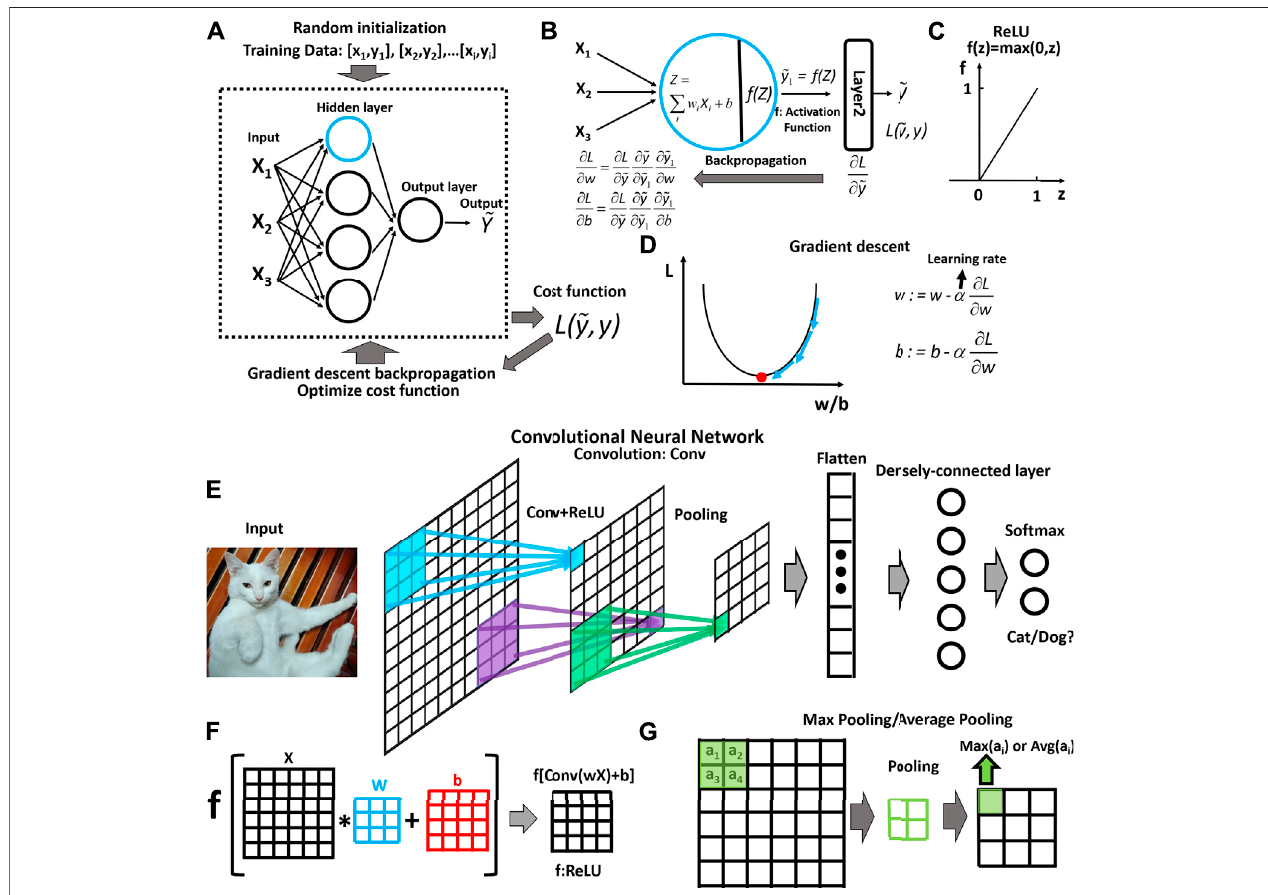
FIGURE 5 | (A) Schematic of a neural network with two fully-connected layers and its training work fl ow, (B) Schematic of the key mathematical operations for a node (highlighted by blue circle): 1) linear operations by introducing weights parameters “ w ” and bias parameters “ b ” ; 2) nonlinear operations by activation functions: such as ReLU, sigmoid, tanh, (B) also shows the backpropagation through chain rule during the training process, (C) An example of the activation function: ReLU is the most popular nonlinear operation. (D) Illustration of optimization process using gradient descent: iterated updated parameters to look for the local minimum, (E) Schematic of a classi fi cation convolutional neural network: 1) the convolutional operation and pooling operation extract the imaging features; 2) fully-connected layers classify the learned high-level feature, (F) Illustration of the convolutional layer and the nonlinear operation. A small kernel with 3 × 3 size is often deployed in this process, (G) Illustration of pooling operations. 2 × 2 is a common choice of pooling patch